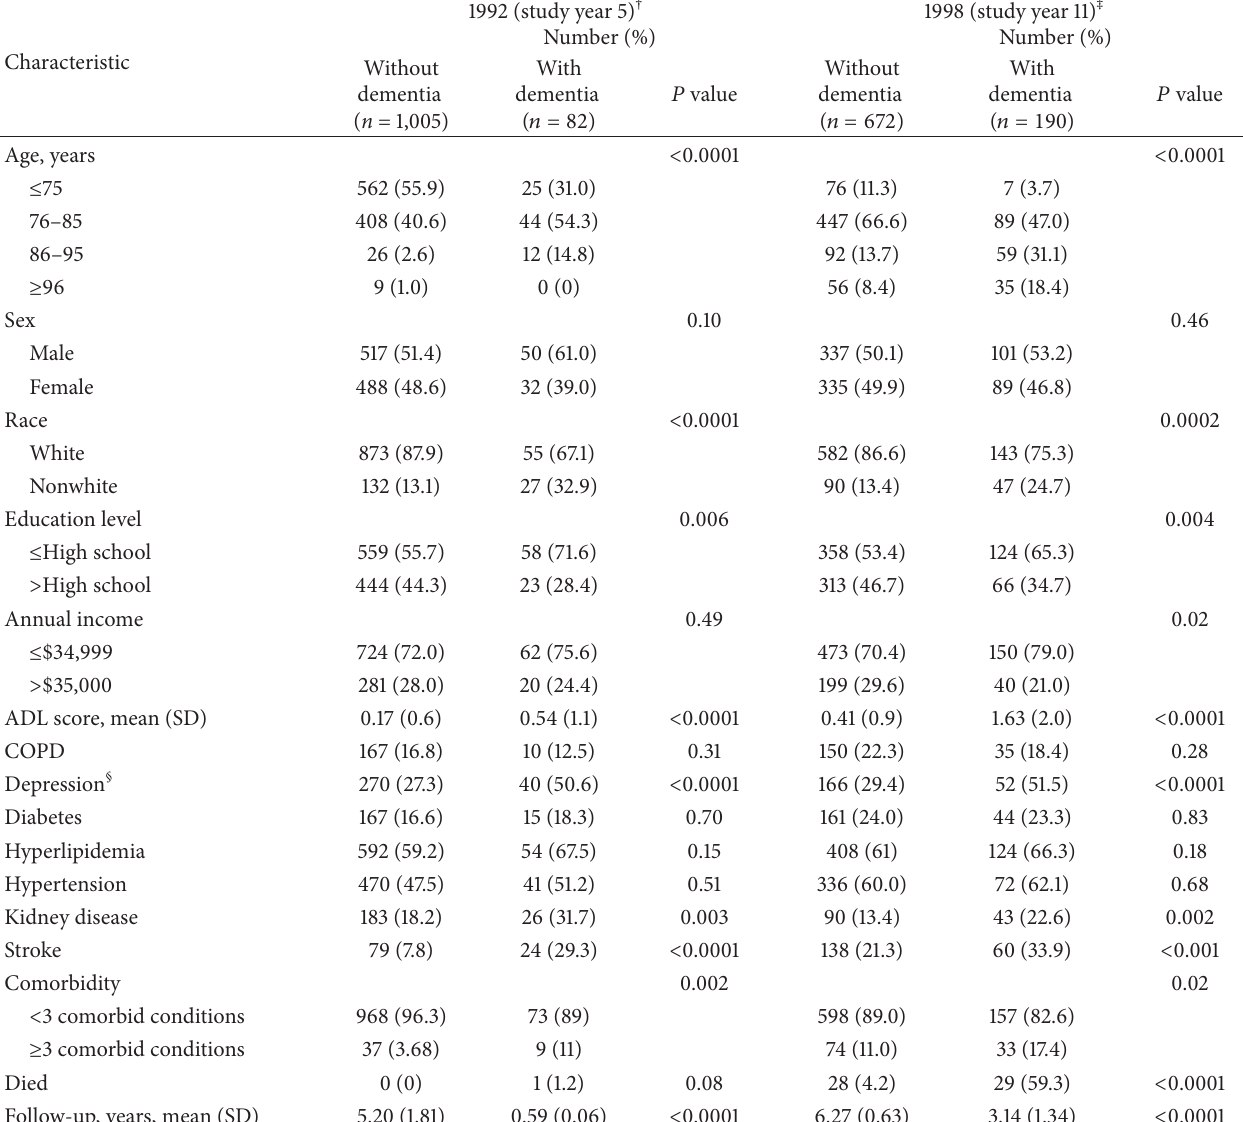
Table 1: Characteristics of study participants in 1992 and 1998, stratified by dementia status ∗